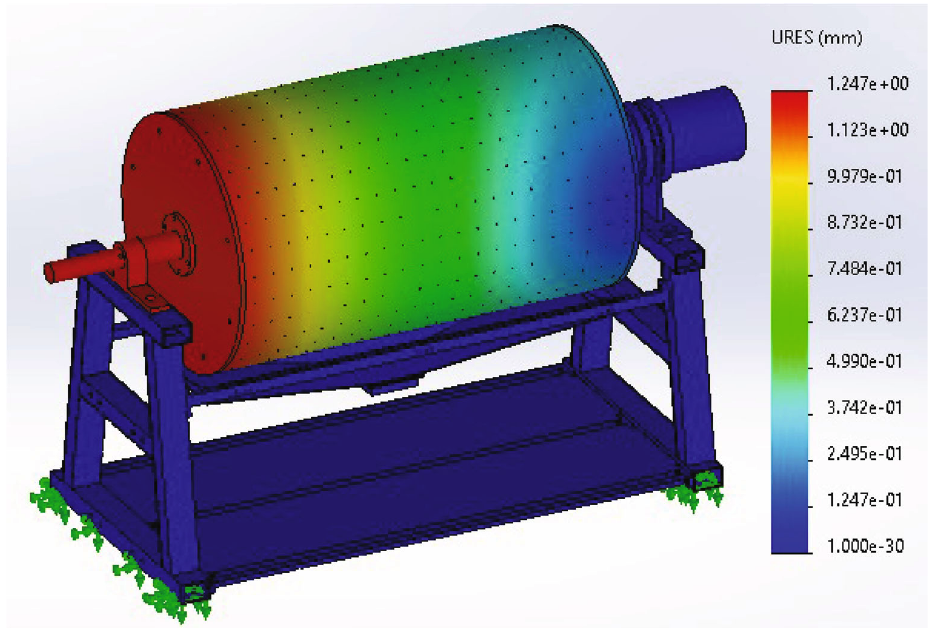
Figure 20: Deformation results